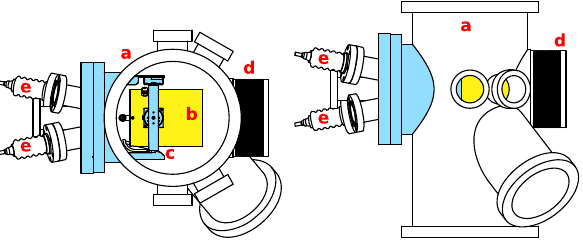
Fig. 3 Detail of the test setup at the KATRIN monitor spectrometer. The electron source is mounted inside the vacuum chamber ( a ). The grounded cage ( b ) contains the plate-capacitor setup and can be tilted on a gimbal mount ( c ). A dipole electrode is located inside the bellow ( d ) that connects the vacuum chamber with the spectrometer beamline. The back and front plate are connected to a high voltage source via vacuum feed-throughs ( e )